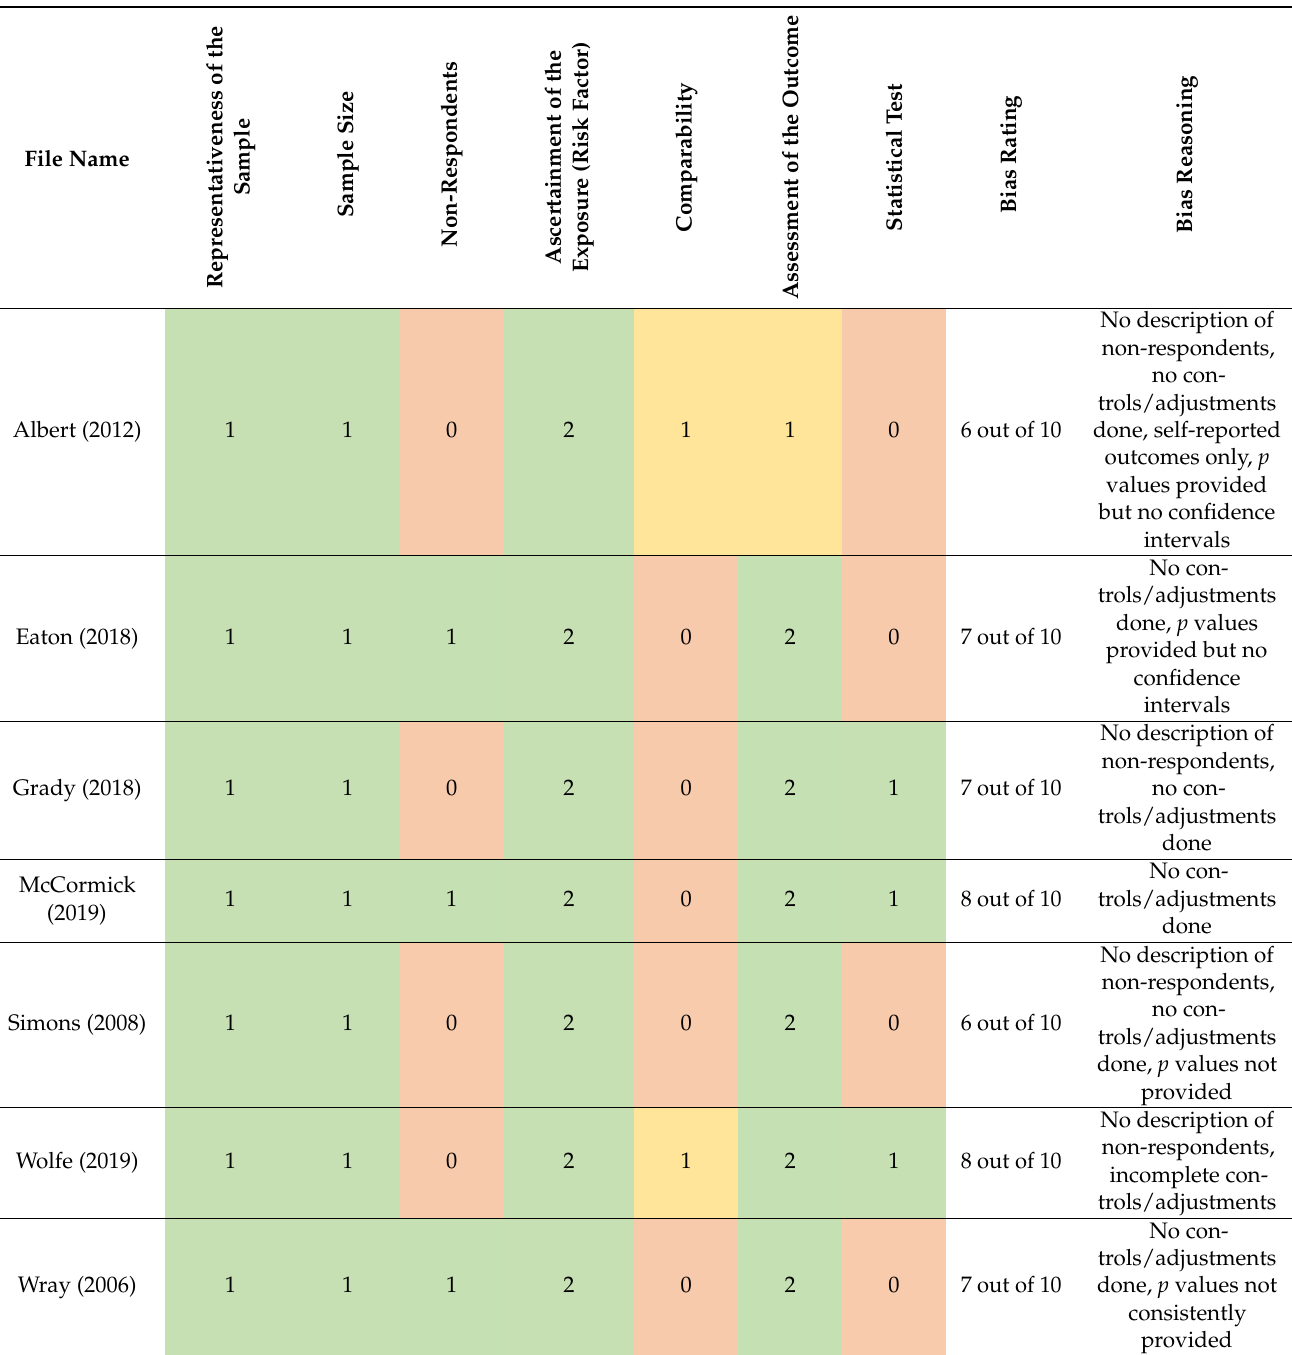
Table 7. Bias rating of cross-sectional studies via modified Newcastle–Ottawa